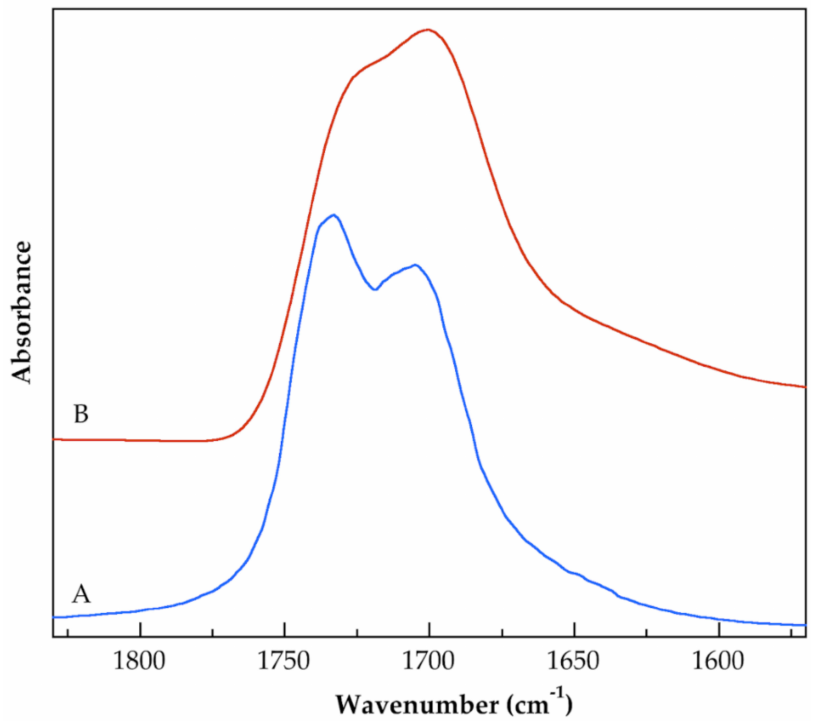
Figure 8. Partial FT-IR spectra in the 1570–1830 cm − 1 region of the purified Mat 2 ( A ) and of the Mat 2 after hydrocortisone release finished ( B